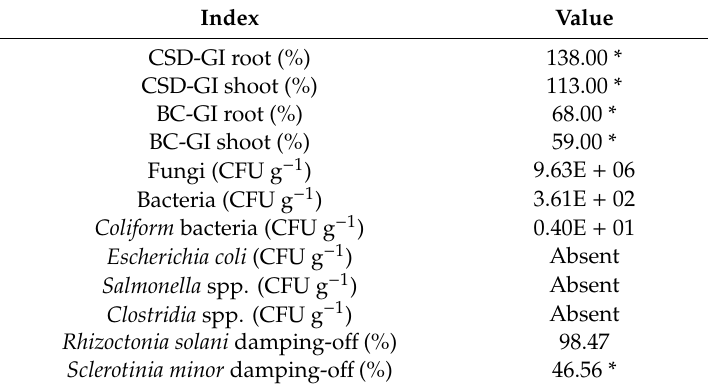
Table 2. PhytotoxicityassessmentofCSDandBCandmicrobiologicalandsuppressivenesscharacterization of